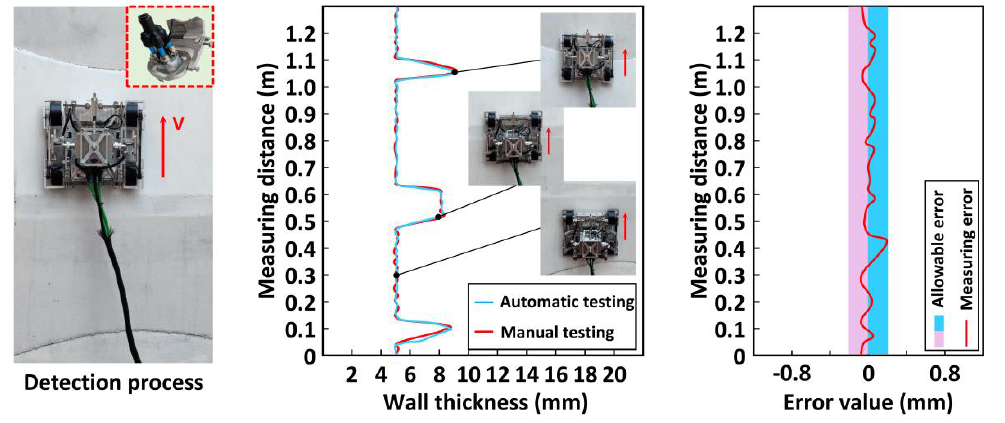
Figure 15. Measurement experiment of wall thickness.